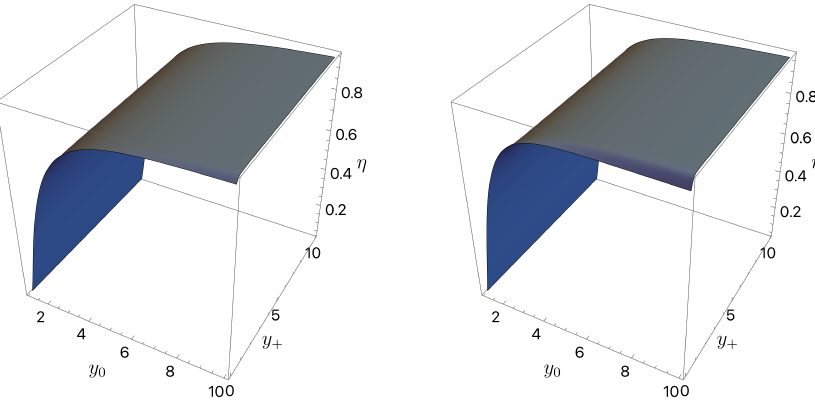
Figure 3 . The quantity η computed for the lowest lying eigenmode with microcanonical boundary conditions as a function of y 0 and y . On the left panel we have d “ 4, while on the right panel ` we take d “ 5. In both cases the results indicate that the mode has positive norm. As a result, the rule-of-thumb from [22] does not Wick-rotate either mode. And since we saw above that they have positive eigenvalues, both modes also define stable directions of the original action before any